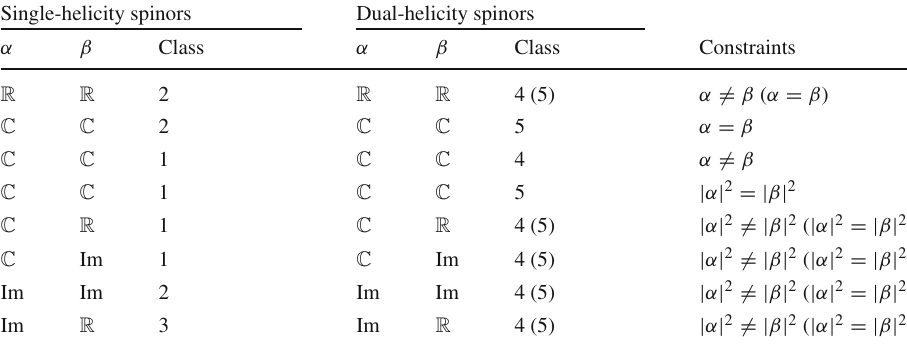
Table 3 Constraints to map the regular and singular sector of the Lounesto’s